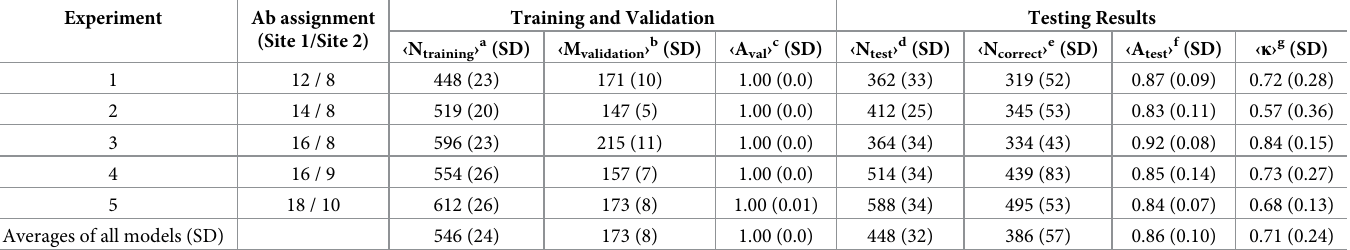
Table 9. Classification of Abs recognizing two distinct epitopes on the HIV-1 GP120/GP41 protein complex. Statistical summary of five experiments in which we trained 50 DNN models using fingerprints colored according to the charge coloring